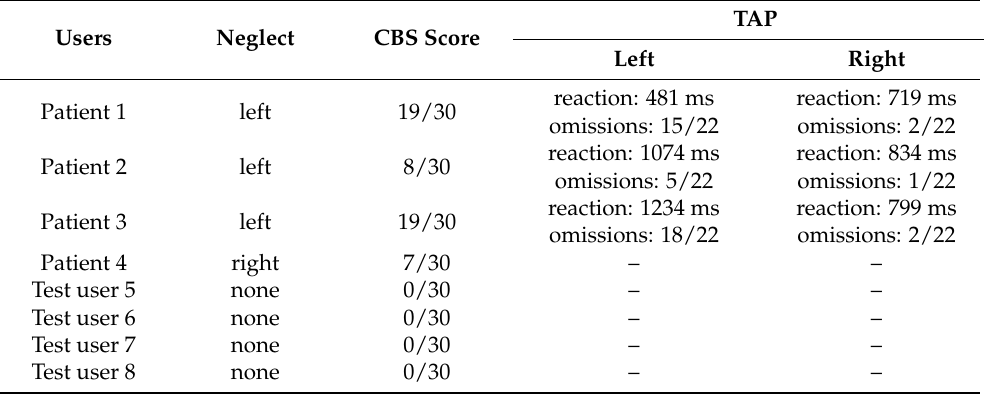
indicates more severe neglect. More omissions and a higher reaction time on one side in the TAP test indicate neglect towards that same